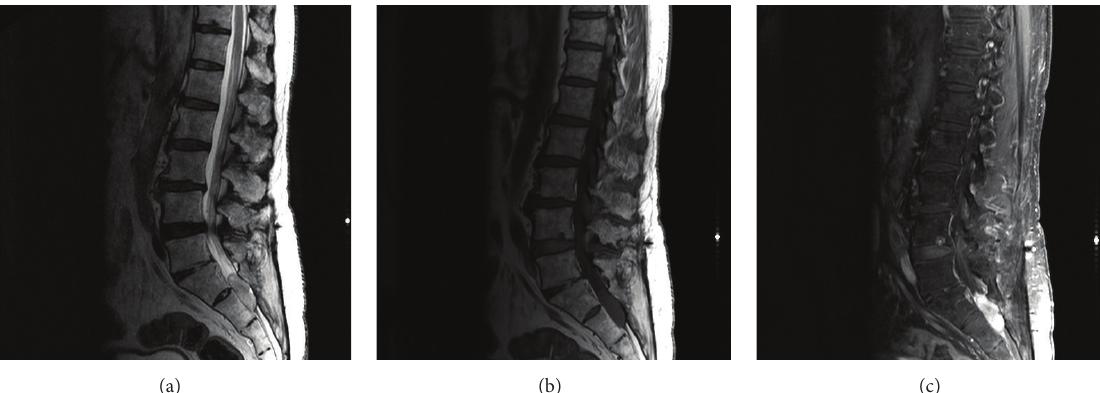
Figure 1: MRI of the lumbar spine with and without contrast. (a) Sagittal T2, (b) sagittal T1, and (c) sagittal T1 after fat saturation: Displays a T1 isointense, T2 hyperintense contrast enhancing mass at the S1-S2 level. The mass measures approx. 3.4 × 1.2 cm without local invasion into surrounding structures.